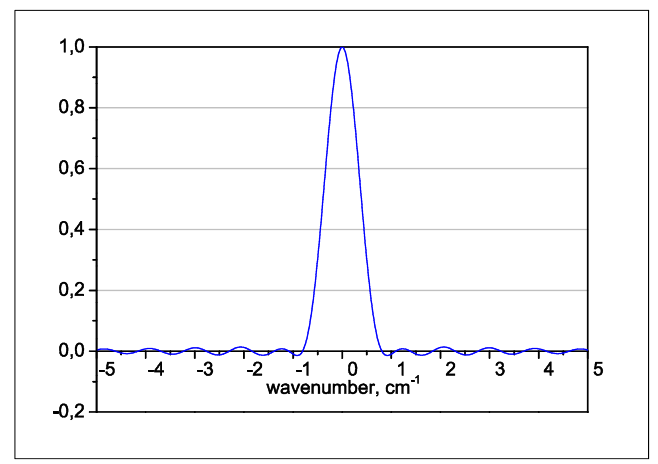
Figure 1. Response function of the Fourier Transform Spectrometer for spectral resolution equal to 0.5 cm −1